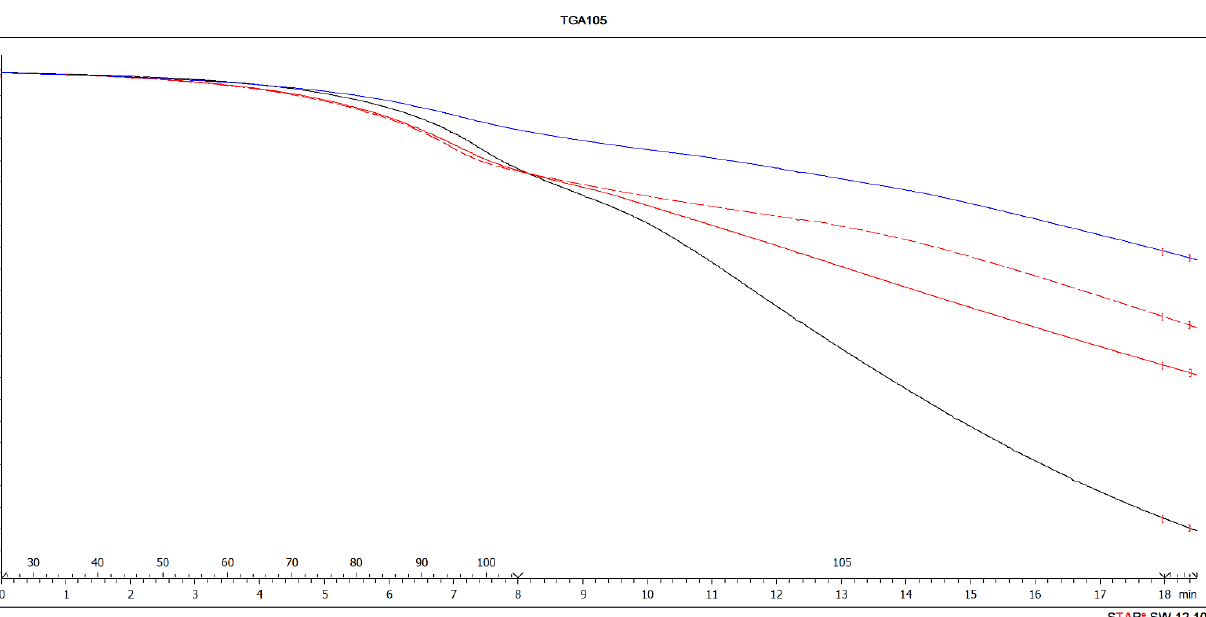
Figure 5. Left part: TGA curves to 105 °C of Ref10 (red dashed line), BB10 (red), BB15(blue), BB20 (black). Right part: the isothermal section at the temperature of 105 °C.